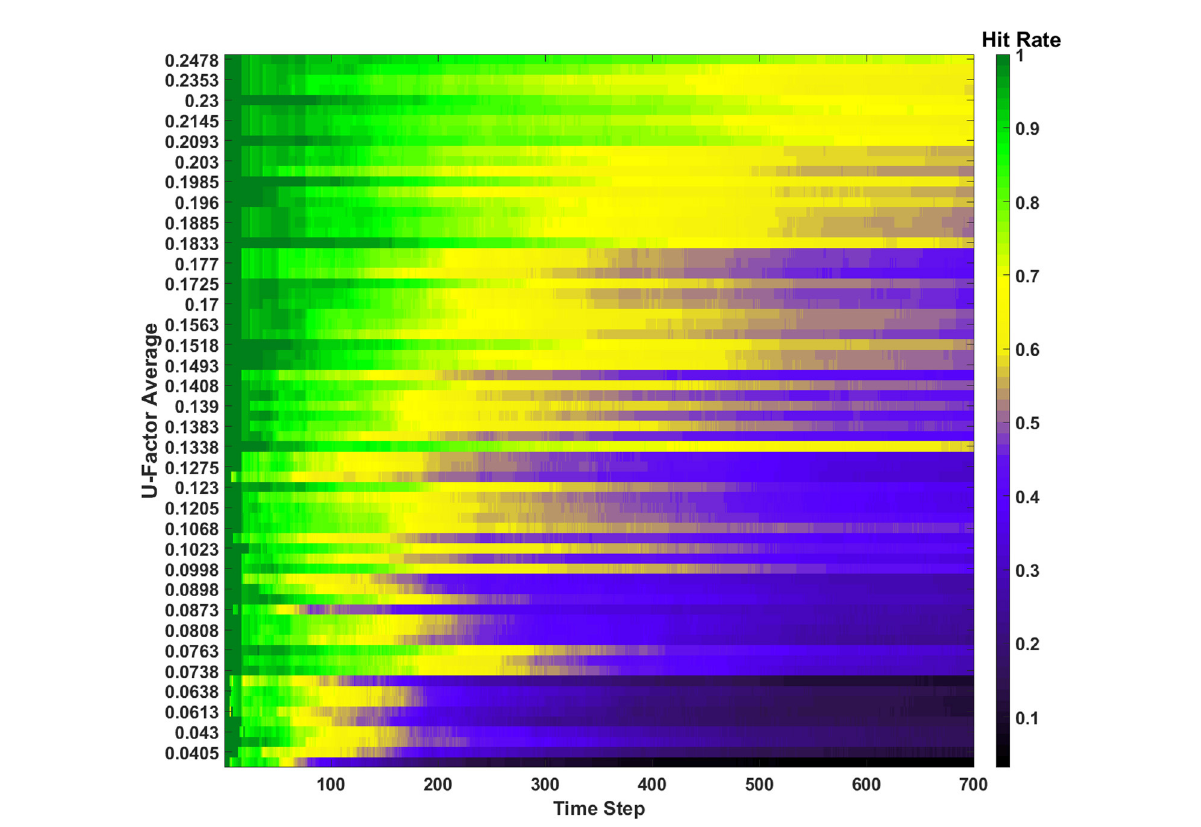
FIGURE3 Hit rate for the baseline of the SAN against the EHoS dataset. The x-axis represents each time step throughout the simulation, while the y-axis represents the average U-Factor value (Table 1) for the four features shown to the network during each recall trial, U avg